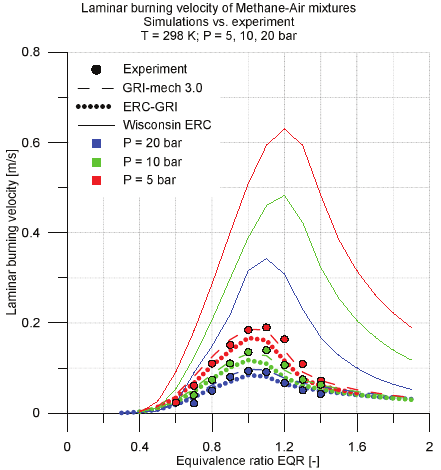
Fig. 4. Validation of LBVs for methane/air mixtures